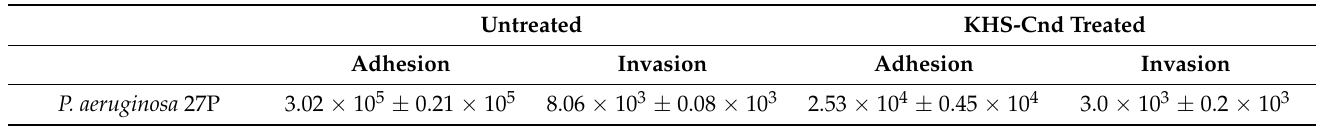
Table 2. The adhesion and invasion capabilities of P. aeruginosa on A549 cells in the presence and absence of 40 µ M KHS-Cnd. Untreated KHS-Cnd Treated Adhesion Invasion Adhesion